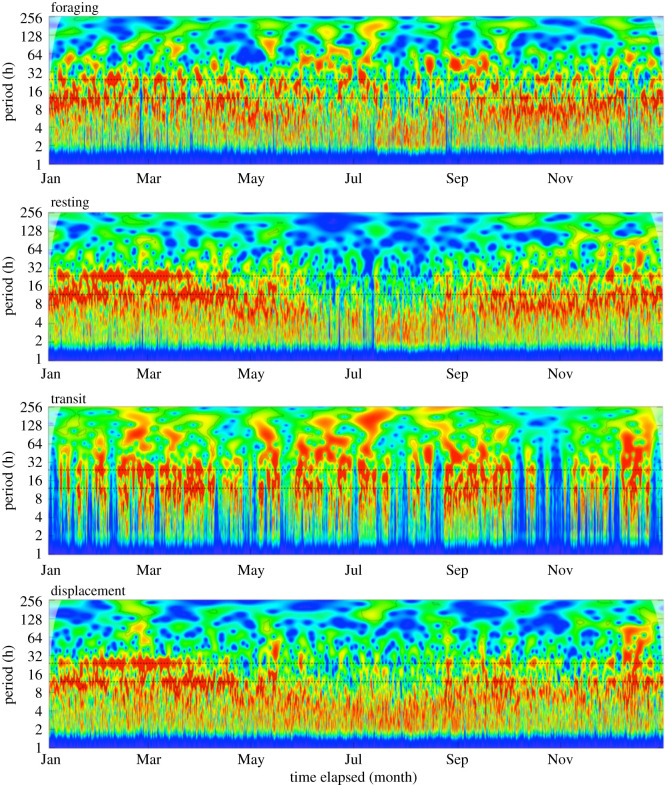
Wavelet power spectra of the probability of foraging, resting, transiting and net hourly displacement over an entire year for a single adult female muskox. Times of the year with strong periodicity and of statistical significance at the 5% level are shown in warmer colours (yellow and red). Times of the year without strong periodicity are shown in cooler colours (green and blue). Power values were normalized between panels to facilitate comparison. Horizontal dashed lines are provided at 12 h and 24 h to highlight periodicity at the ultradian and circadian scales, respectively. Wavelet power spectra for all individuals are provided in [44].